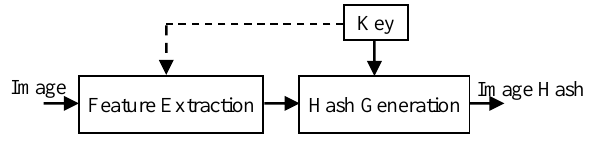
Figure 1. Two main stages of the general image hashing